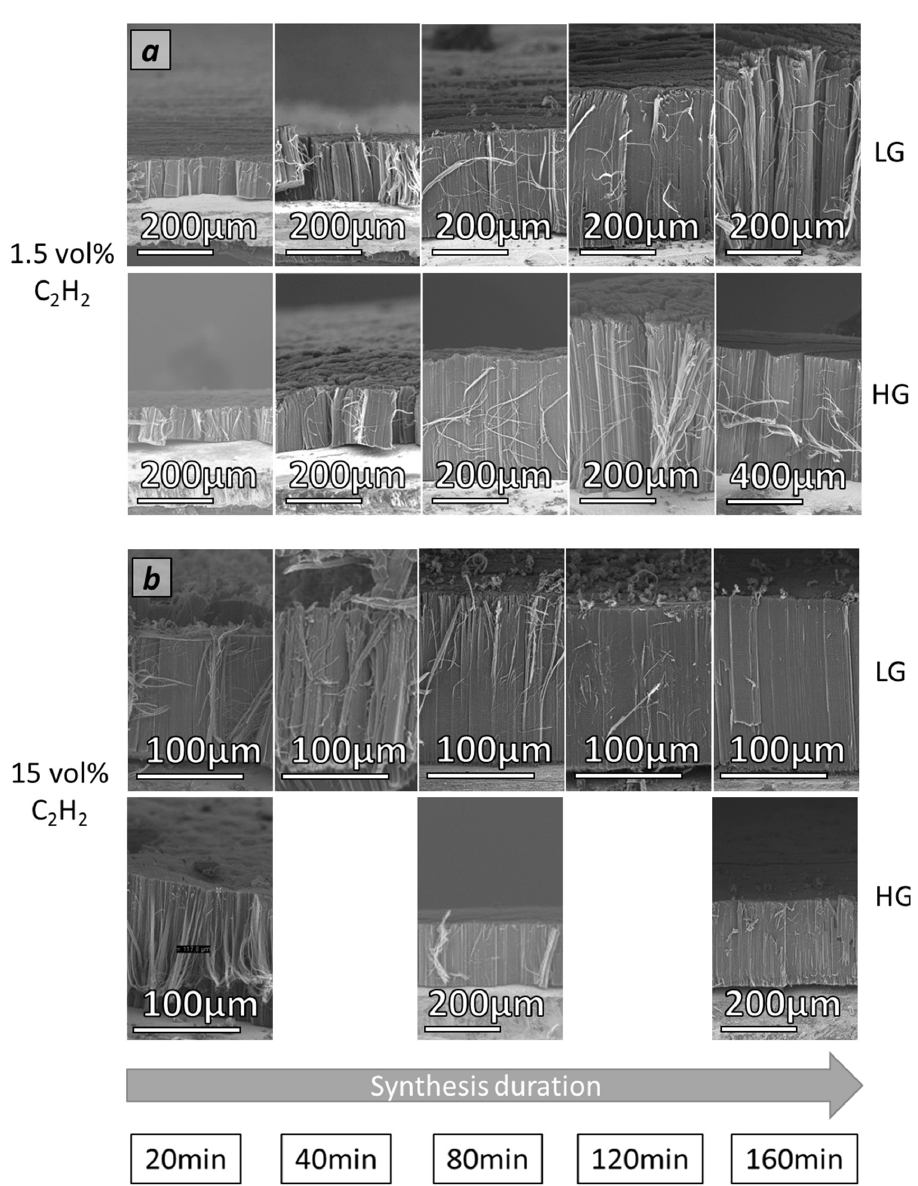
Figure 4. SEM micrographs of VACNT samples obtained on LG-Al and HG-Al substrates from ( a ) 1.5 vol% of C 2 H 2 and ( b ) 15 vol% of C 2 H 2 and for different synthesis durations. VACNT carpet thickness (i.e., CNT length) versus synthesis duration for different